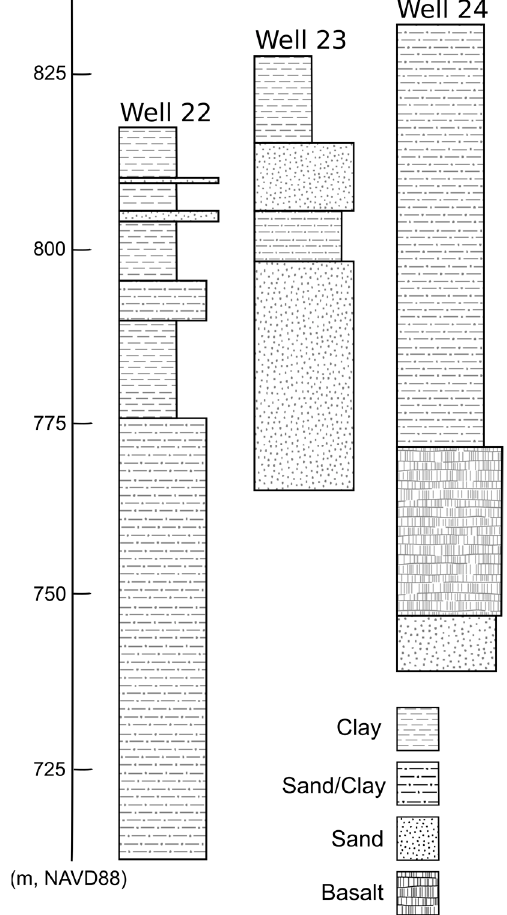
Figure 15. Stratigraphy of sediment deposits for wells 22, 23, and 24 (Table 1 and Figure 10), displaying the heterogeneity of the aquifer matrix.